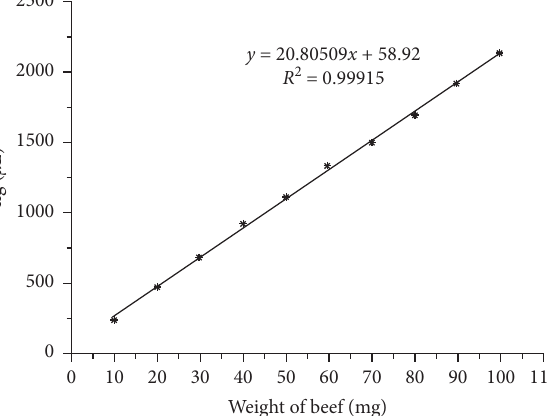
Figure 4: The relationship between the DNA content and the copy number of beef samples.